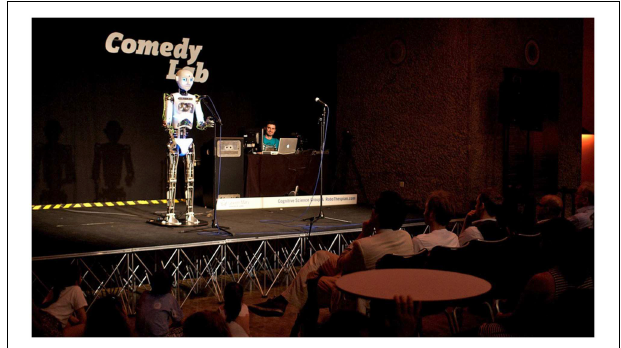
FIGURE 2 | Comedy Lab with RoboThespian TM at the Barbican Centre in